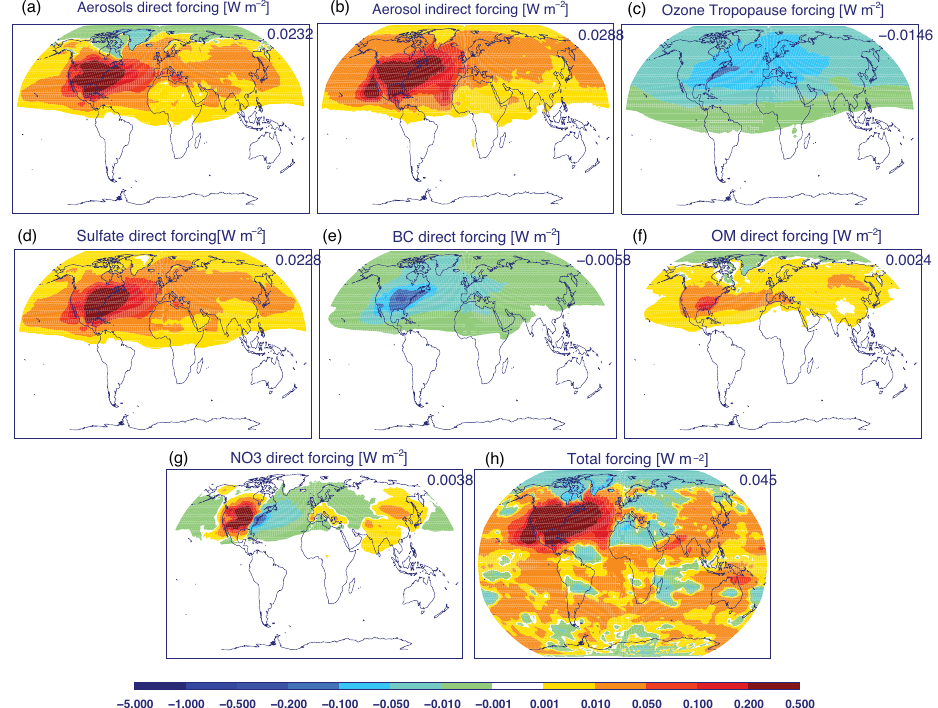
Figure 11. Impact of the air quality regulations (AQ30) on radiative forcing in 2030 relative to